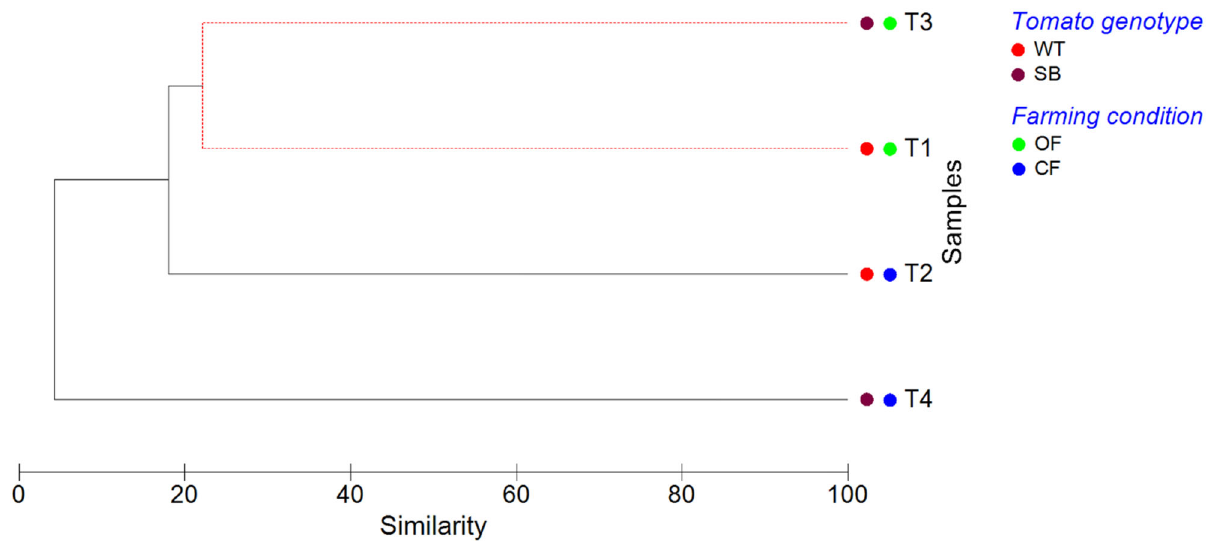
Figure 8. Cluster analysis dendrogram showing similarities/dissimilarities among the experimental conditions based on their OTU composition. The clustering analysis (complete linkage) was performed on Bray–Curtis dissimilarity data, applying SIMPROF routine to test significance. Solid black lines indicate samples that are significantly different ( p < 0.05), whereas dashed red lines indicate groups of samples that are not significantly different ( p > 0.05), according to SIMPROF test.